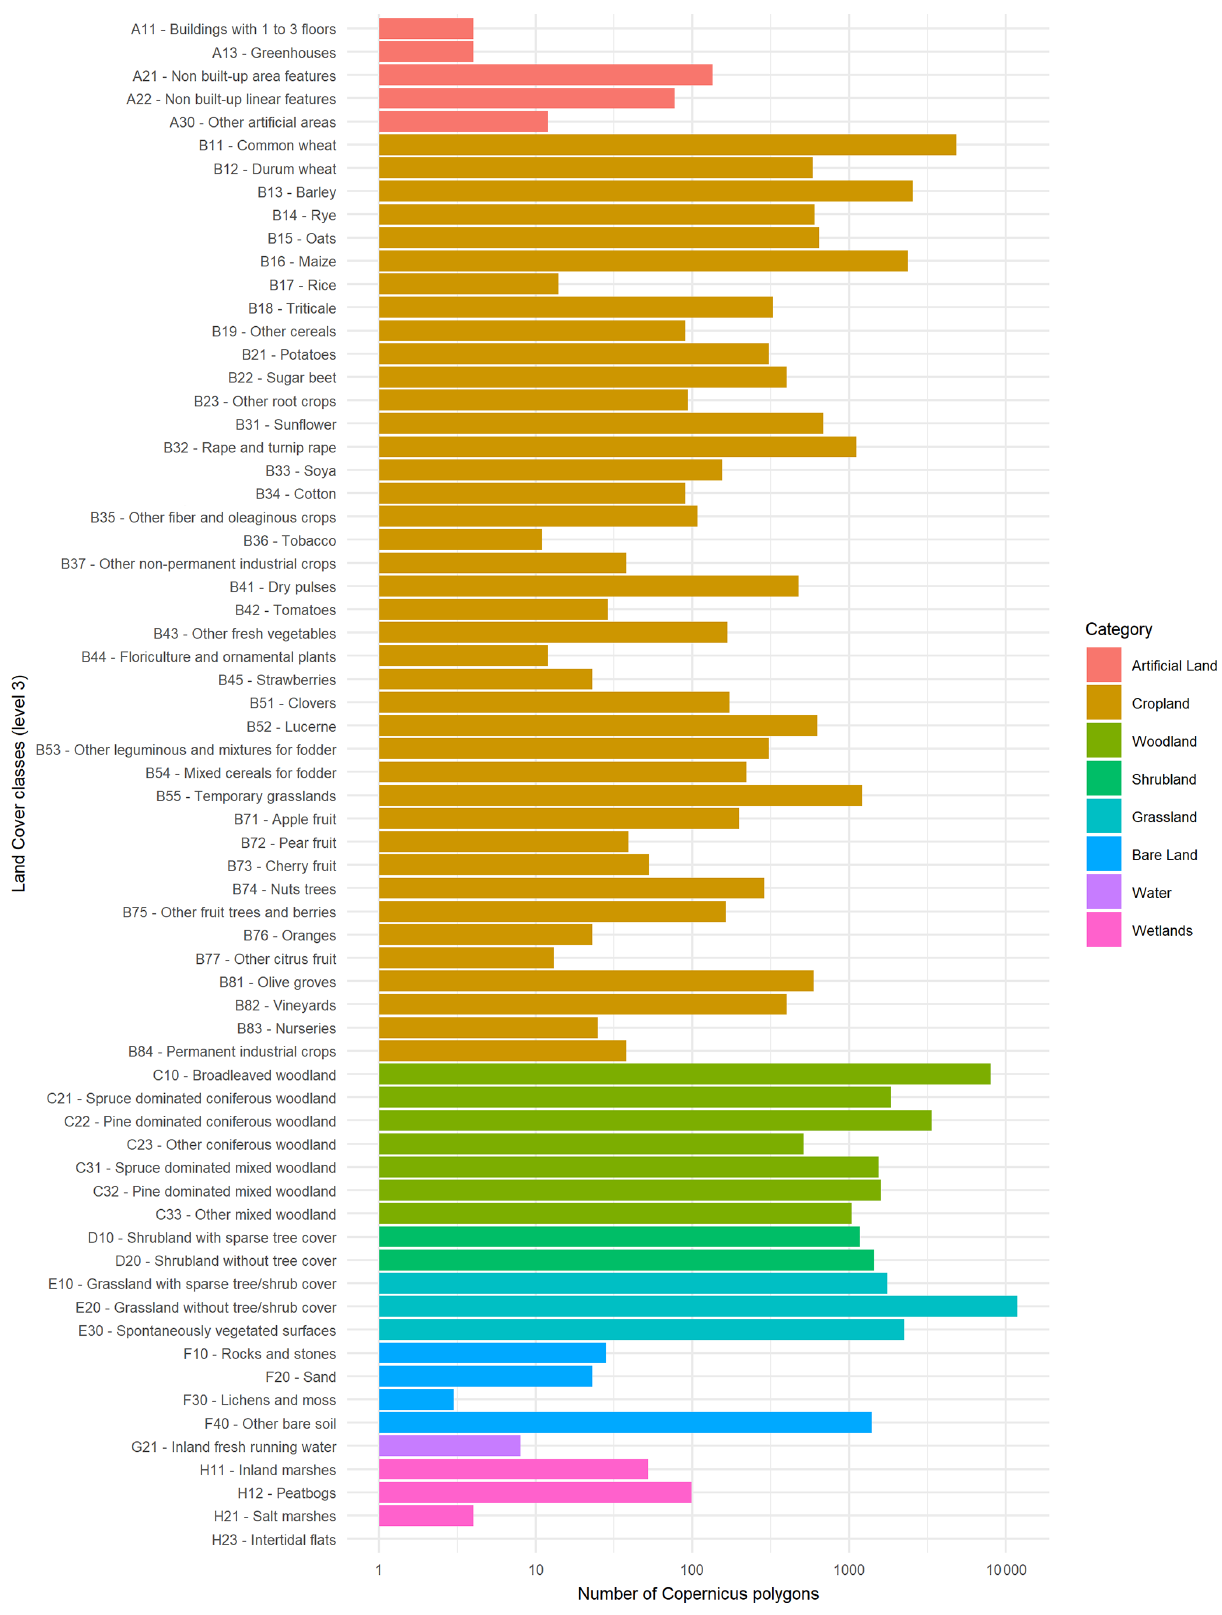
Figure 5. Distribution of level-3 land cover (inherited from LUCAS core) for the LUCAS Copernicus polygons ( N = 58426). https://doi.org/10.5194/essd-13-1119-2021 Earth Syst. Sci. Data, 13, 1119–1133,